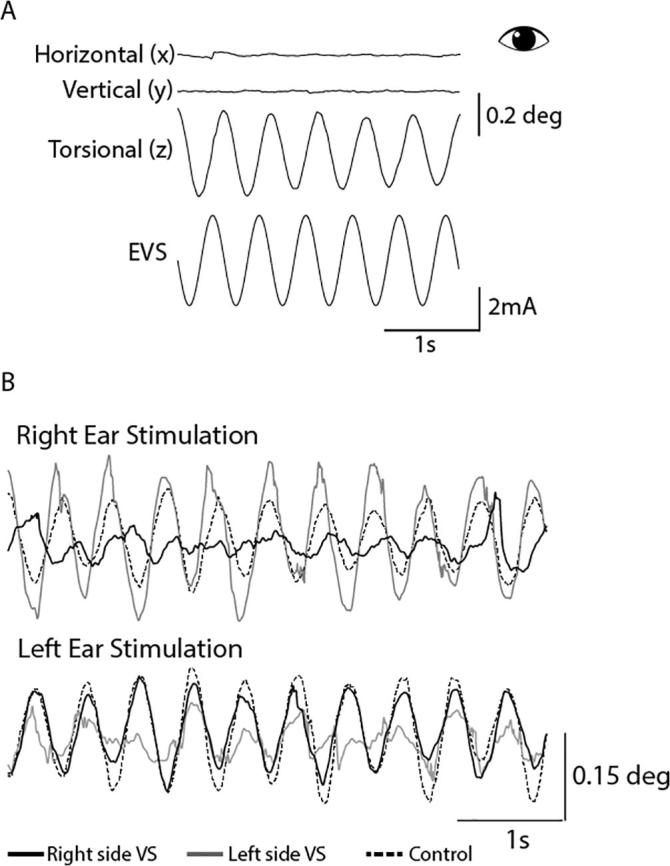
3D eye movements evoked by EVS stimulation. (A) A representative control participant. EVS induces a sensation of head roll about the naso-occipital axis. This leads to the torsional (z) eye movements being much larger than both the horizontal (x) and vertical (y) components of the eye movements. For this reason, only torsional eye movements were analysed. (B) A healthy individual (black dashed trace) shows a similar response gain when either the right or left ear is stimulated. However, the vestibular schwannoma patients show a reduced response magnitude during ipsilesional stimulation (solid black and grey traces).